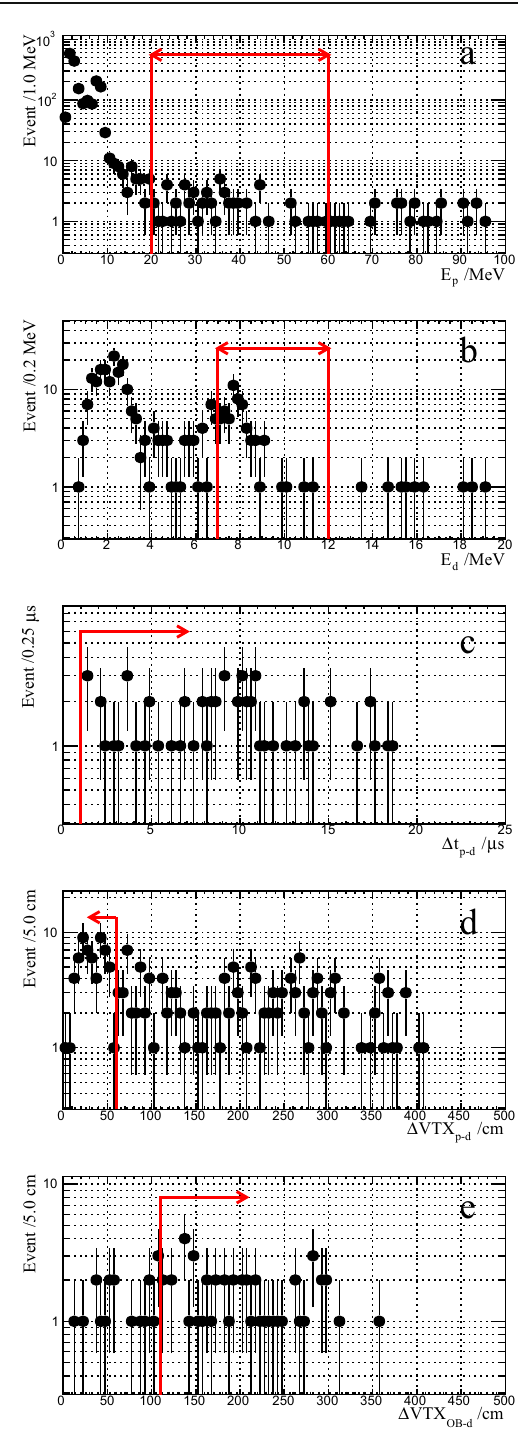
Fig. 2 The distributions of the variables used in the IBD selection: a E p , b E d , c (cid:3) t p − d , d (cid:3) VTX p − d and e (cid:3) VTX OB − d . Each distribution has all of the selection criteria applied, except for the selection on the variable displayed. The red arrows show the selection criteria of each